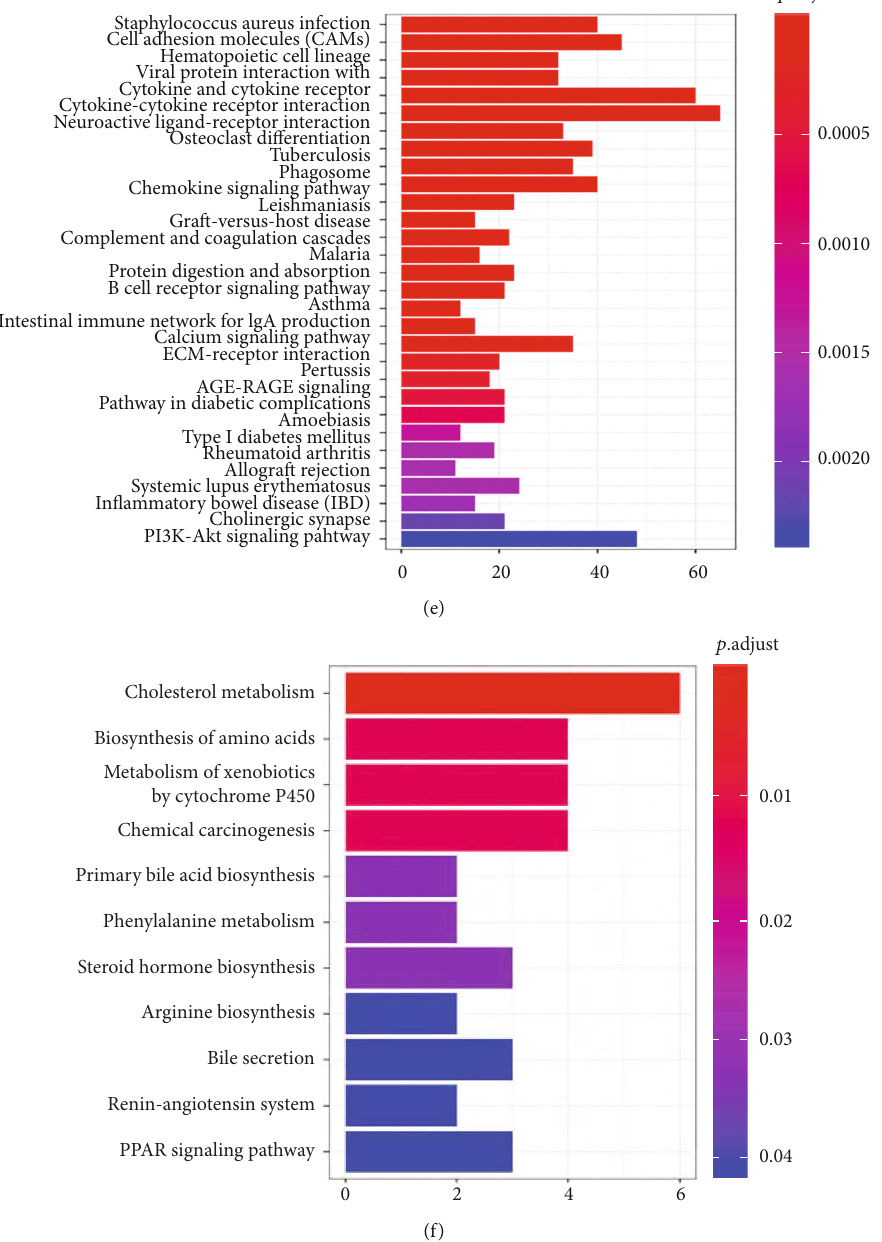
Figure 5: Alterations in signaling pathways in the hot and cold groups. (a) Heatmap showed the DEGs between hot and cold tumors. (b) Volcano plot showed the DEGs between hot and cold tumors. (c, d) GO enrichment analysis of hot and cold tumors. (e, f) KEGG enrichment analysis of hot and cold